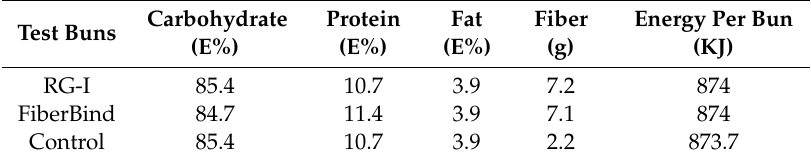
Table 1. Composition of the three test buns.